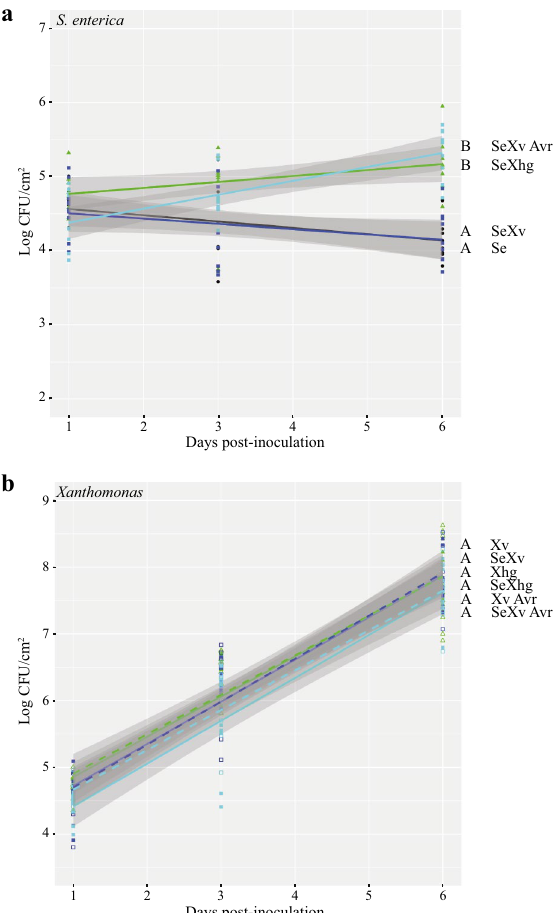
Figure 2. AvrHah1 is sufficient for Xanthomonas -dependent increases in S. enterica populations. Bacterial populations ( S. enterica , ( a ); Xanthomonas ( b )) on tomato leaves were monitored following treatment with S. enterica (Se; black circles), Xhg (Xhg; open green triangles), X. vesicatoria pUFR034 (Xv; open blue squares), X. vesicatoria pUFR034 ( avrHah1 ) (Xv Avr; open cyan squares), S. enterica + Xhg (SeXhg; closed green triangles), S. enterica + X. vesicatoria pUFR034 (SeXv; closed blue squares), or S. enterica + X. vesicatoria pUFR034 ( avrHah1 ) (SeXv Avr; closed cyan squares). All data points from three independent experiments are presented as log CFU/ cm 2 . Lines (black, S. enterica, Se; dashed green, Xhg, Xhg; dashed blue, X. vesicatoria pUFR034, Xv; dashed cyan, X. vesicatoria pUFR034 ( avrHah1 ), Xv Avr; solid green, S. enterica + Xhg, SeXhg; solid blue, S. enterica + X. vesicatoria, SeXv ; solid cyan, S. enterica + X. vesicatoria pUFR034 ( avrHah1 ), SeXv Avr) correspond to a linear regression model with 95% confidence intervals represented by the shaded areas. Letters denote significant differences between treatments for the regression lines according to the linear regression model ( P < 0.01). Combining three independent experiments, n = 9 plants per treatment per time point.